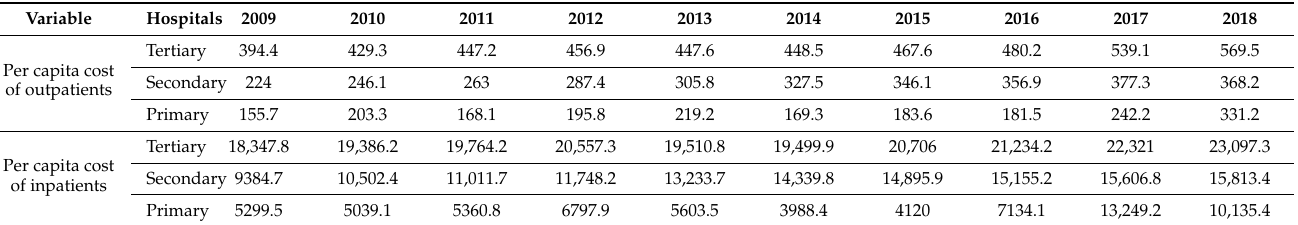
Table 11. Per capita cost of outpatients and inpatients of different level public hospitals in Beijing from 2009 to 2018 (Yuan).